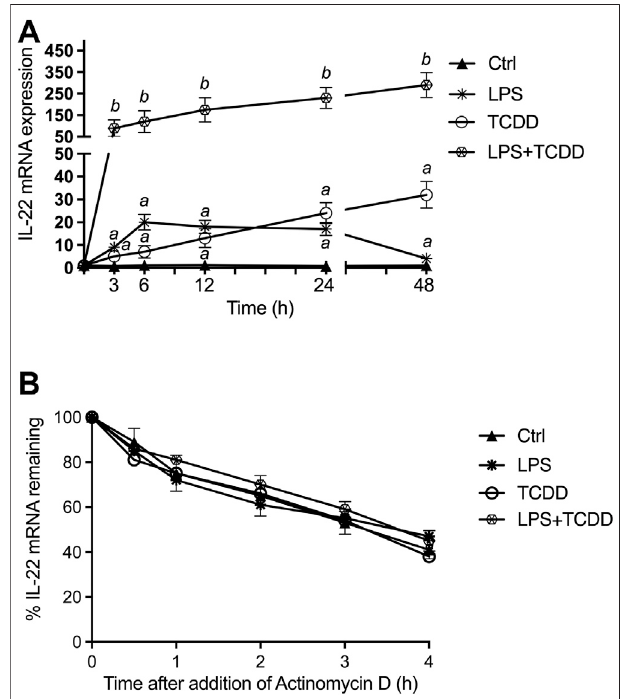
FIGURE 1 | Synergistic effect of AhR and TLR4 activation on IL-22 mRNA expression. (A) Synergistic effect of TCDD and LPS on time- dependentexpressionofIL-22inBMM.BMMderivedfrom8-weekoldfemale B6 wt mice were treated with LPS (1.0 μ g/ml), TCDD (1 nM), or